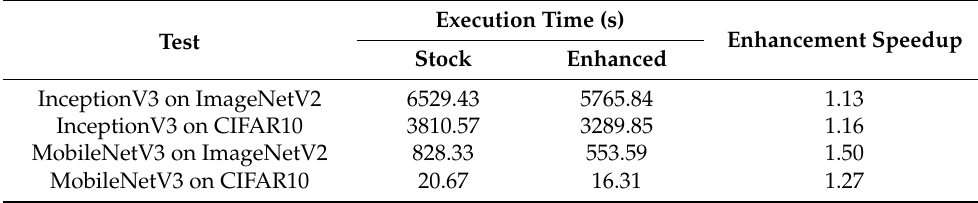
Table 5. Results for Experiment 1 using the enhancements for Pi 4B.